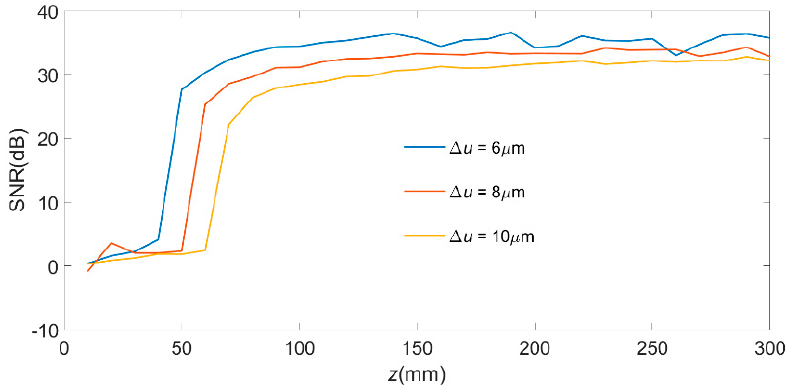
Figure 7. Accuracies of the diffraction calculation with different sampling rates in the observation plane.